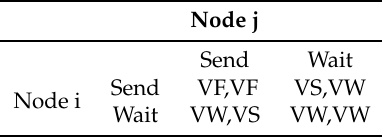
Table 1. Game benefit of two nodes contend